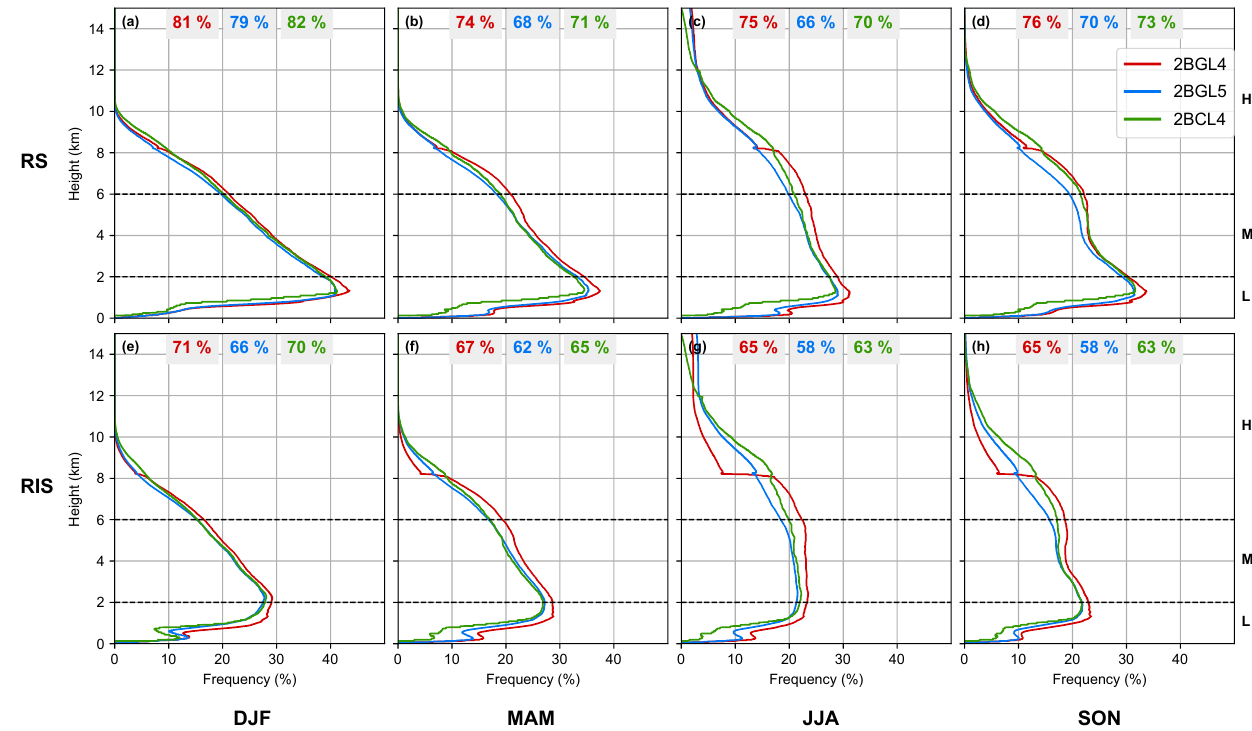
Figure 2. Mean vertical profiles of cloud occurrence derived from the 2BGL4, 2BGL5 and 2BCL4 data for the Ross Sea (a–d) and RIS sectors (e–h) for different seasons. Total sector cloud fraction (temporal average cloud occurrence independent of altitude) is annotated at the top of each sub-figure. L, M, and H labels indicate the low, medium, and high cloud regions, respectively, as discussed in the text.